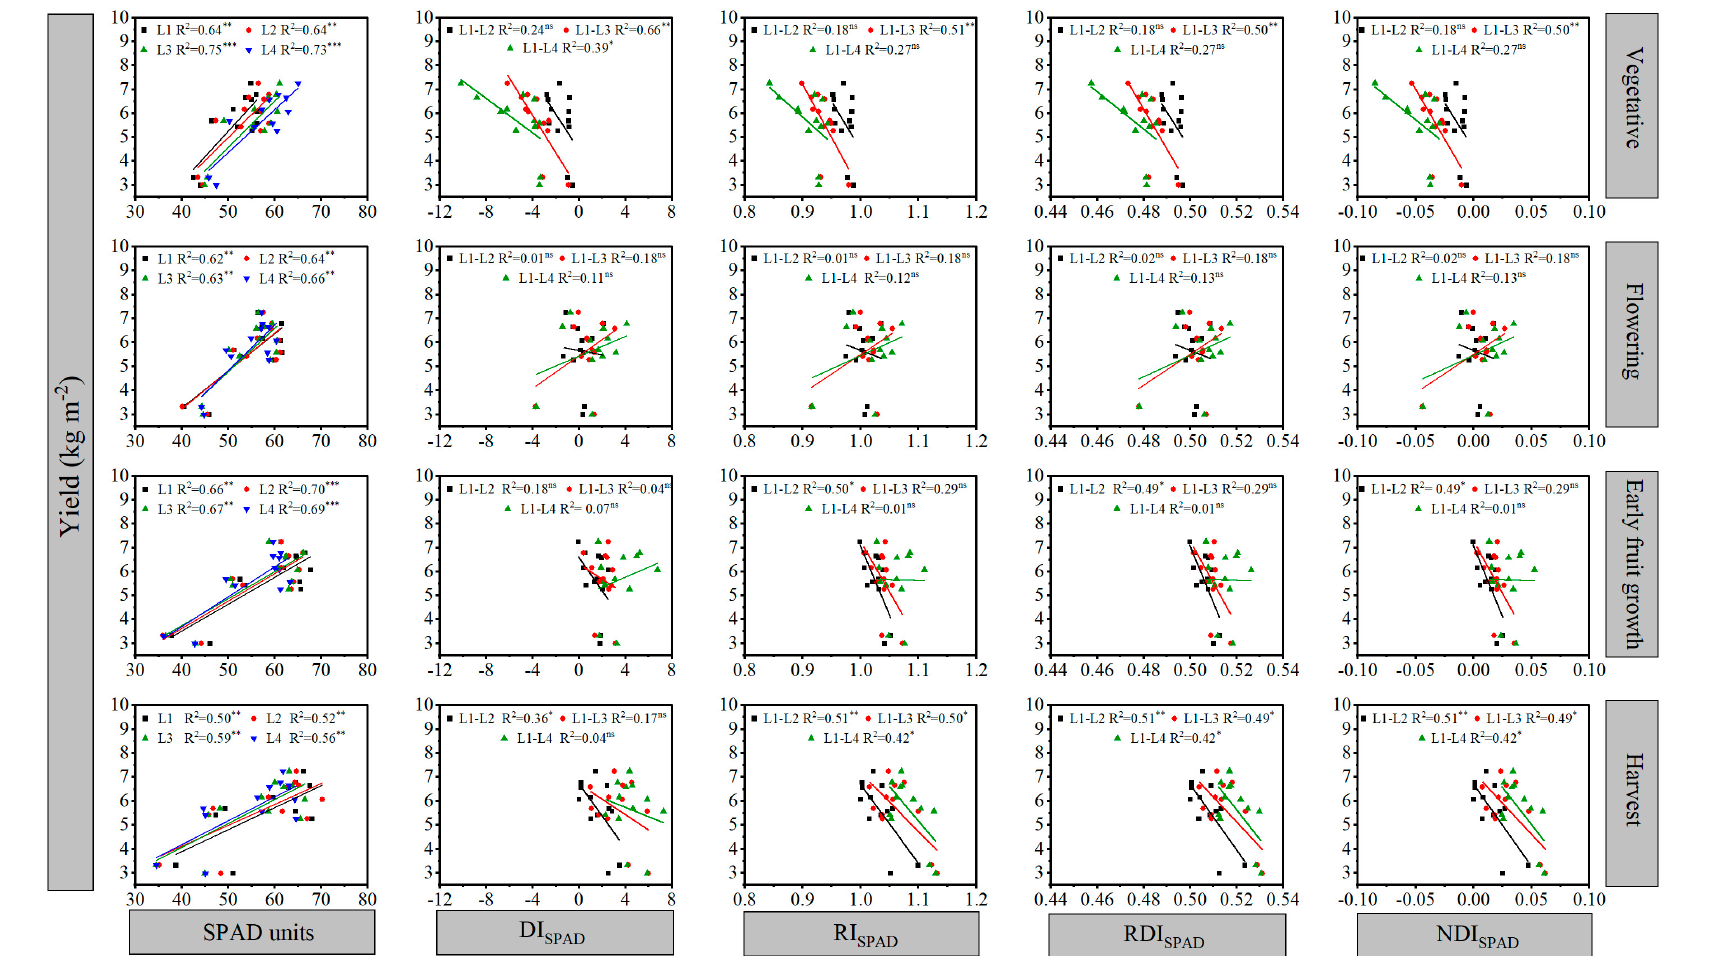
Figure 2. The relationships between absolute SPAD measurements and several normalized SPAD indices (DI, RI, RDS, NDI) with total fruit yield (kg m − 2 ) at different phenological stages of sweet pepper, for calibration data. L1, L2, L3 and L4, refer to the latest (most recent), second, third and fourth fully expanded leaf, respectively. Asterisks show significance of regressions: ***, p < 0.001; **, p < 0.01; *, p < 0.05; ns, p > 0.05.